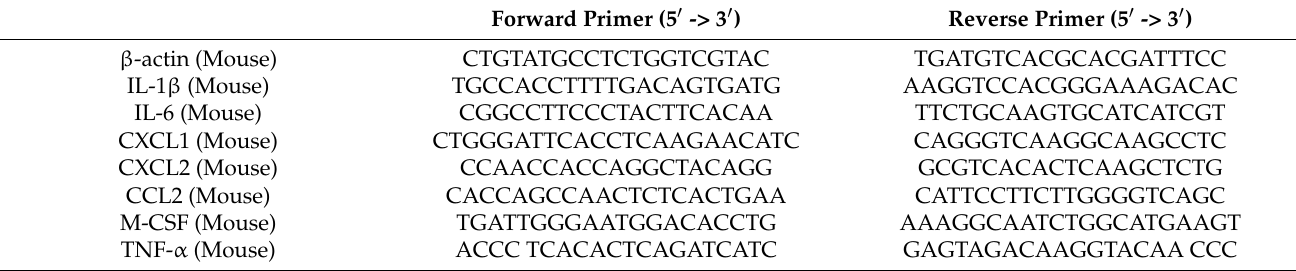
Table 1. Primers for